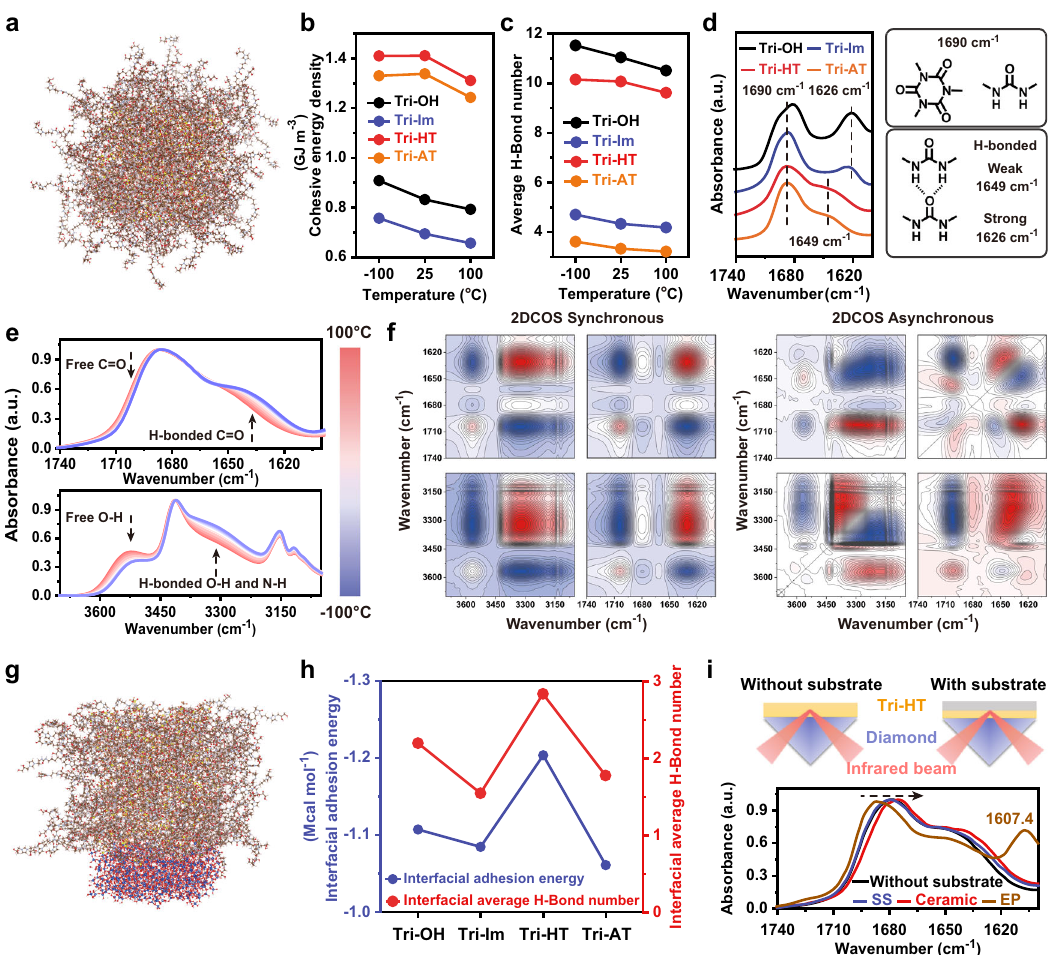
Fig. 4 | Internal and external interactions ofTri-HT. a Most stable conformation with a minimum energy of Tri-HT without the polyhydric substrate. b CED and c average H-bond number of Tri-HT and reference compounds at different tem- peratures. d FT-IR spectra showing the difference of C=O characteristic groups in Tri-HT and reference compounds. e Temperature-dependent FT-IR spectra of Tri- HT upon cooling from 100 to − 100°C (interval: 20°C). f Two-dimensional COS